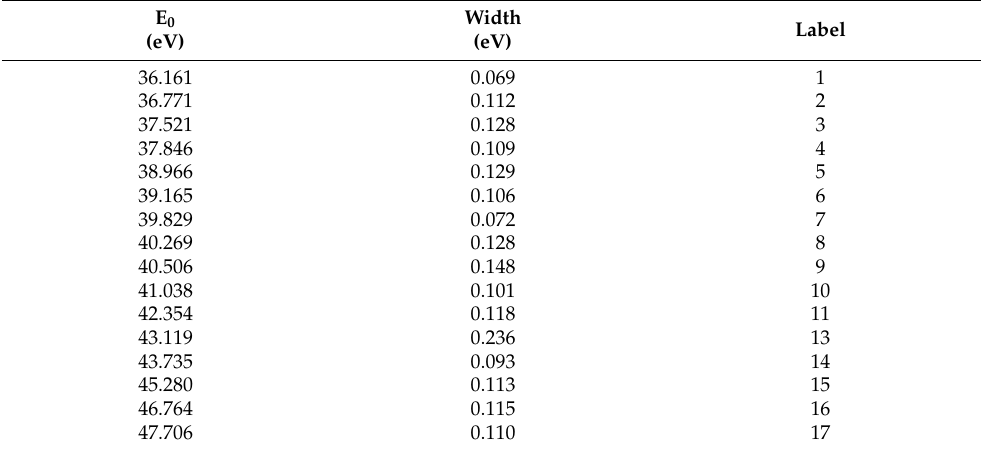
Table 3. Cl 2 + single-photon photoionization resonance energies E 0 and widths derived from Gaus- sian fits to the resonant peaks. Labels correspond to those in Figure 1. E 0